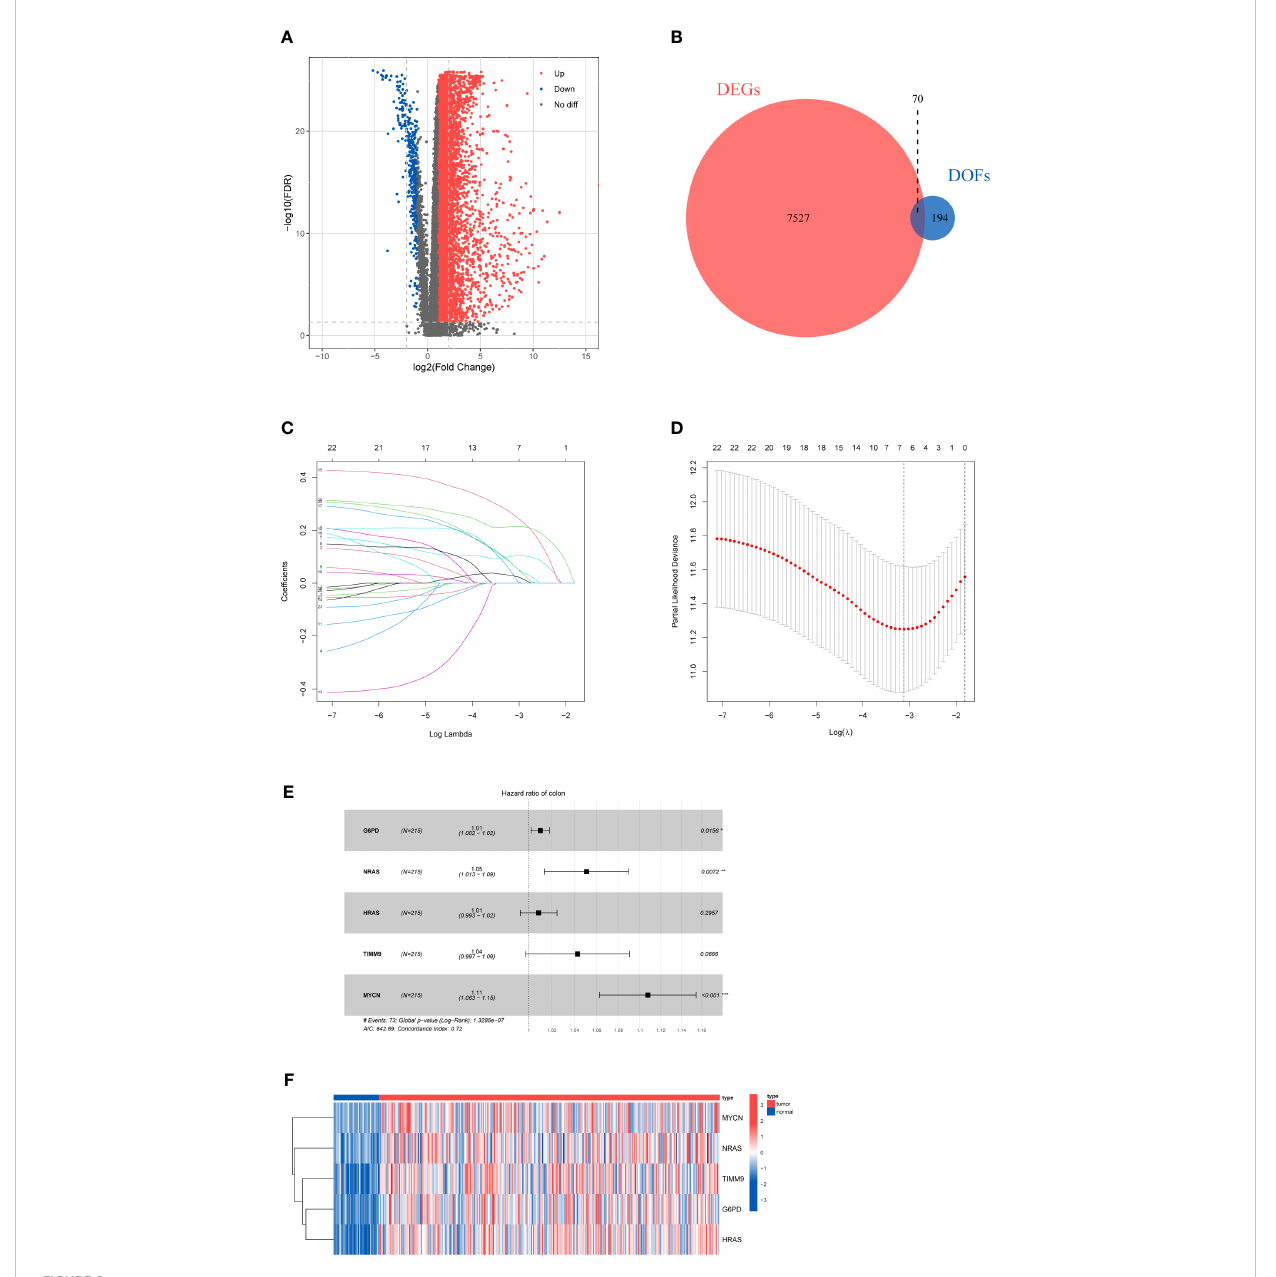
FIGURE 2 Results of differential gene analysis (A) Volcano map of the expression of ferroptosis-related genes in normal and tumor samples. (B) Venn diagram of the differentially expressed genes and DOFs. (C) Lasso coef fi cient pro fi les of 23 DOFs. (D) Tuning parameter in the lasso model. (E) Five DOFs were fi nally identi fi ed by multivariate cox regression. (F) The heatmap of fi ve-gene signature